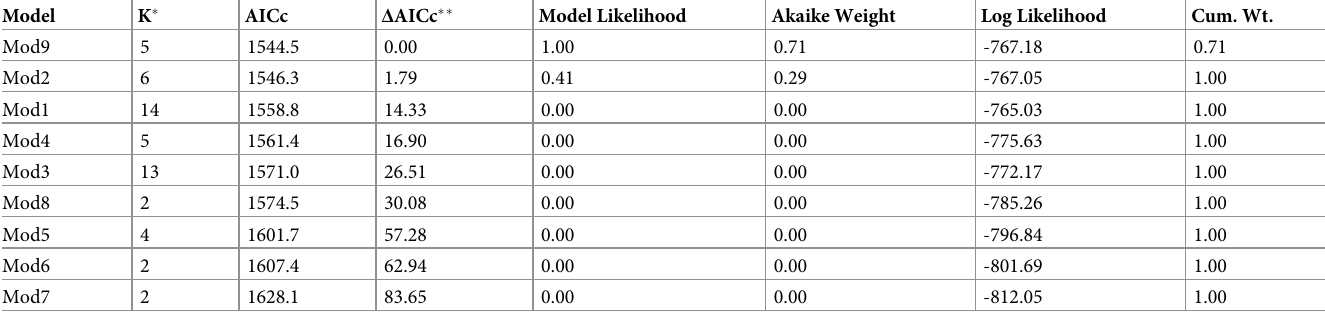
Table 3. Generalized linear model selection results for overall completeness across 123 FWS and NMFS consultations.